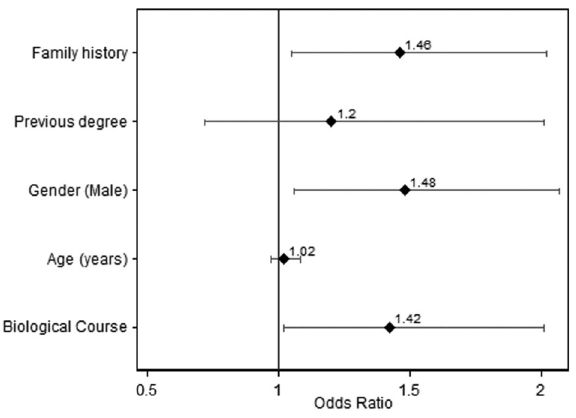
Figure 3. Odds ratios and 95% con fi dence intervals for interest in taking a fi rst aid course among fi rst-year undergraduates at